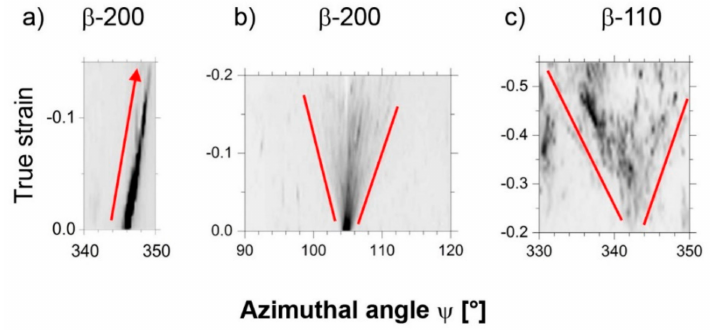
Figure 8. Magnified regions of Figure 4 showing details of ( a ) crystallite rotation, ( b ) misorientation formation, and ( c ) sub-grain